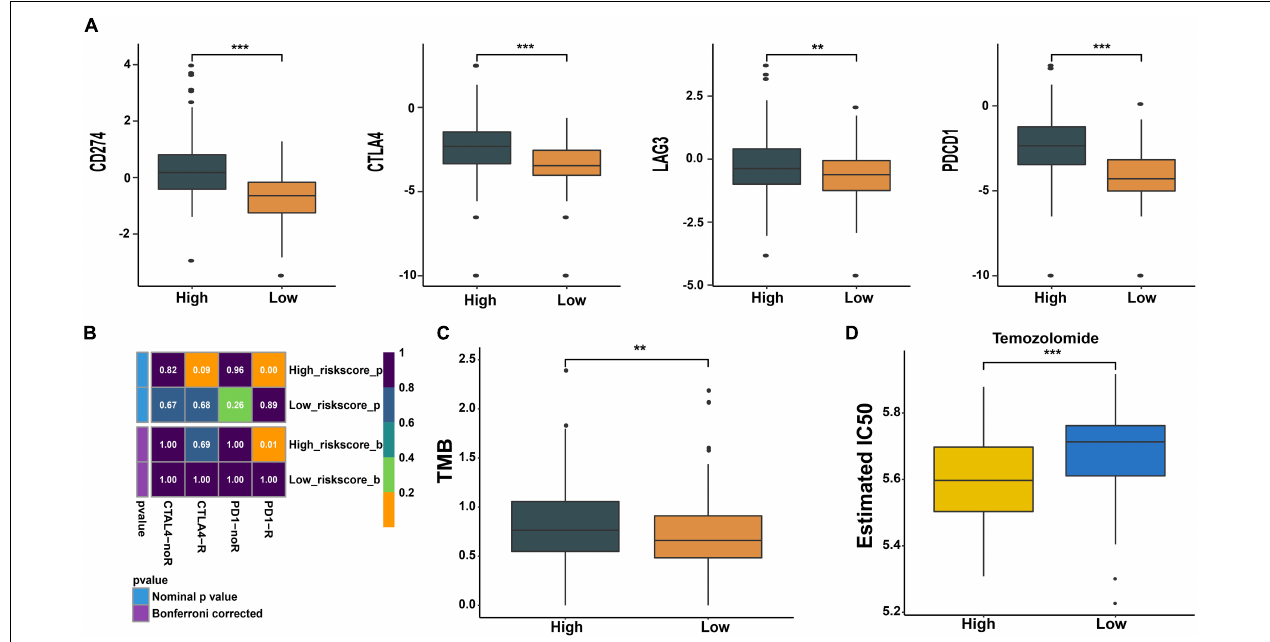
FIGURE 8 | Prediction of response to immunotherapy and chemotherapy. (A) Expression of immune checkpoints in high- and low-risk groups. (B) The analysis of response to immunotherapy. (C) Comparison of TMB between the two groups. (D) The estimated IC50 value of temozolomide (TMZ) in the two groups. ** p < 0.01, *** p <